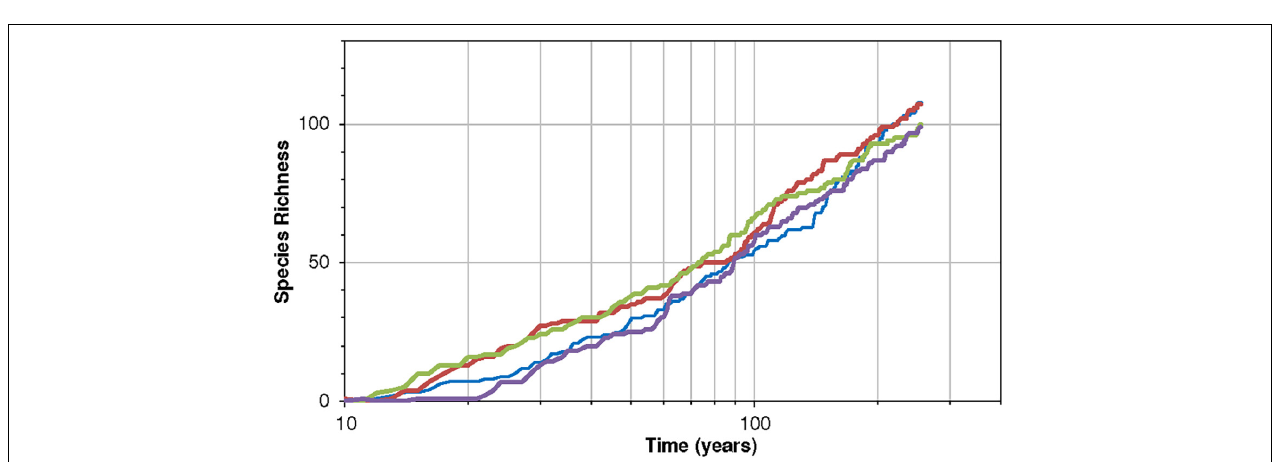
FIGURE 7 | Four realizations of the species-time relationship for the community, with parameters K = 7 and B = 1.7, J = 4 × 10 4 for 256 time-steps and the minimum viable population is M = 11. Notice the near linearity of the rise on a logarithmic scale of time (years). The probability of colonization is constant at 0.007 per species per year. The dynamics are according to Equations (11)–(13) and thus include